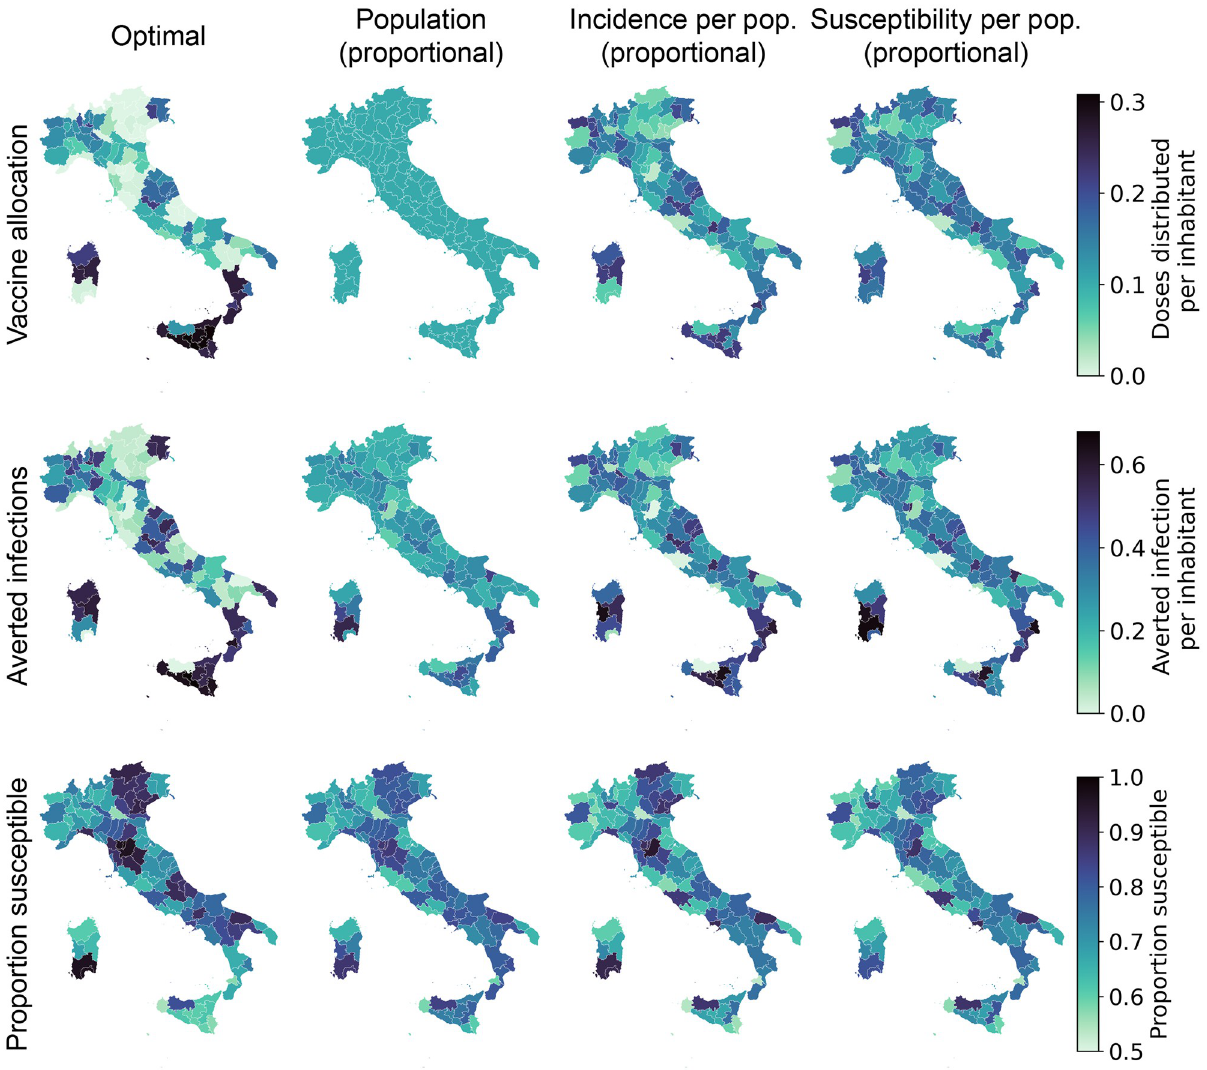
Fig 5. Spatial distribution patterns for the optimal allocation (left) and alternative strategies based on population, incidence, and susceptibility (additional alternative strategies are presented in section E and F in S1 Text). We show, for each province and strategy, the proportion of vaccinated individuals after the implementation of the strategy (top), the number of averted infections per inhabitant with respect to a no vaccination baseline (middle), and the proportion of individuals who are still susceptible at the end of the control horizon (bottom) for the pessimistic transmission scenario with a weekly stockpile delivery of 479’700 doses. Base map layer from the Istituto Nazionale di Statistica; Istat, istat.it, CC-BY